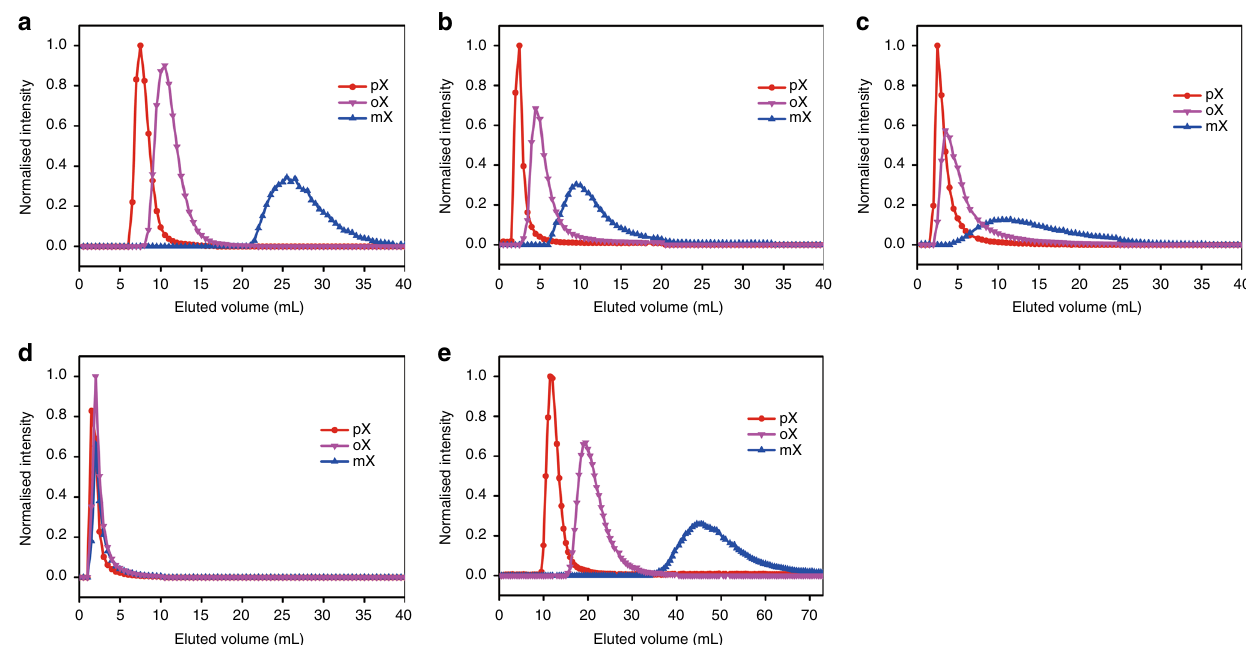
Fig. 2 Chromatographic separation of equimolar mixture of o -, m - and p -xylene in different columns. a MFM-300(In), b MFM-300(V), c MFM-300 (Fe), d MFM-300 (Al) and e two columns in series comprising MFM-300(In) and MFM-300(V). Measurements were undertaken at 293 K. Table 2 Summary of physical properties of three xylene isomers 4,9 . Xylene isomer o -xylene m -xylene p